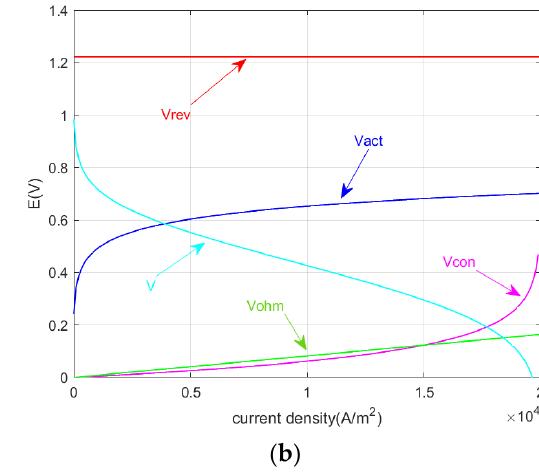
Figure 1. ( a ) Comparisons of the predicted model potential and the experimental data; ( b ) Curves of the potential and output voltage versus the current density.